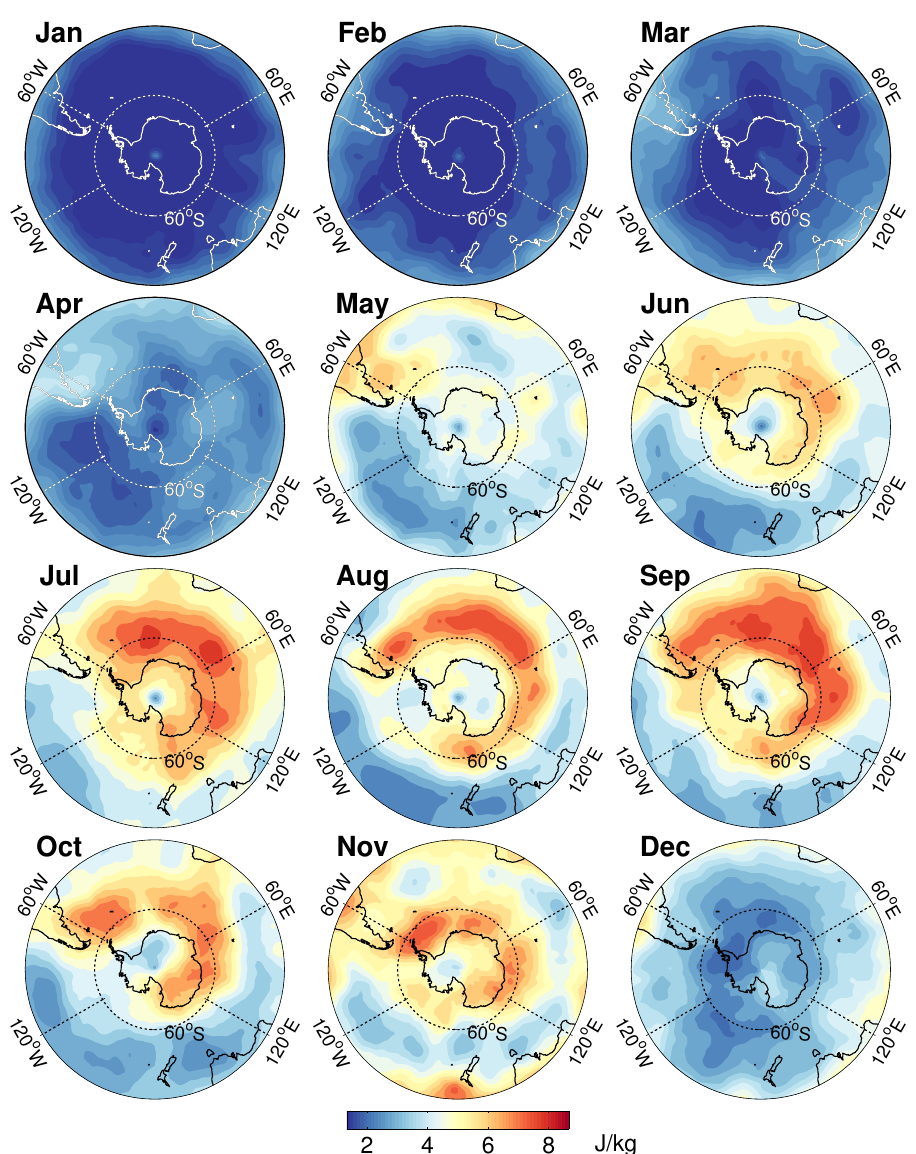
Figure 2. Polar stereo projections of monthly-mean potential energy per unit mass E p in the Southern Hemisphere averaged over the height range 26–36km ( ∼ 20–5hPa) for each month in